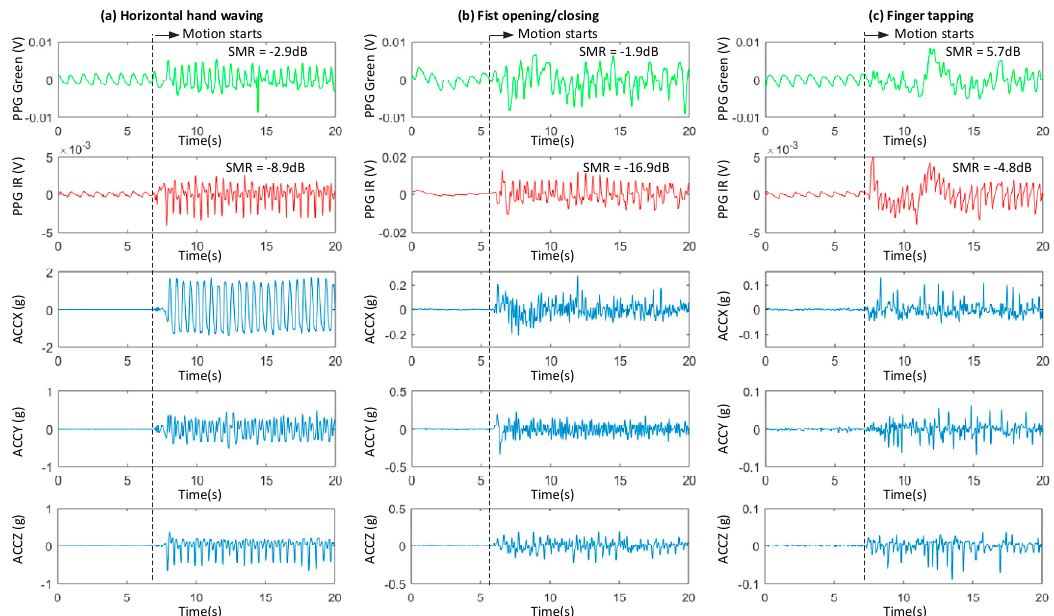
Figure 1. Recorded Green/IRPPG and 3-axis acceleration data (X, Y and Z) during 3 types of periodic motion: ( a ) Horizontal hand waving; ( b ) Fist opening/closing; ( c ) Finger tapping (index finger). Note that the scales of the y-axes are different, due to different magnitudes of the signals. The signal to motion ratio (SMR) is embedded.